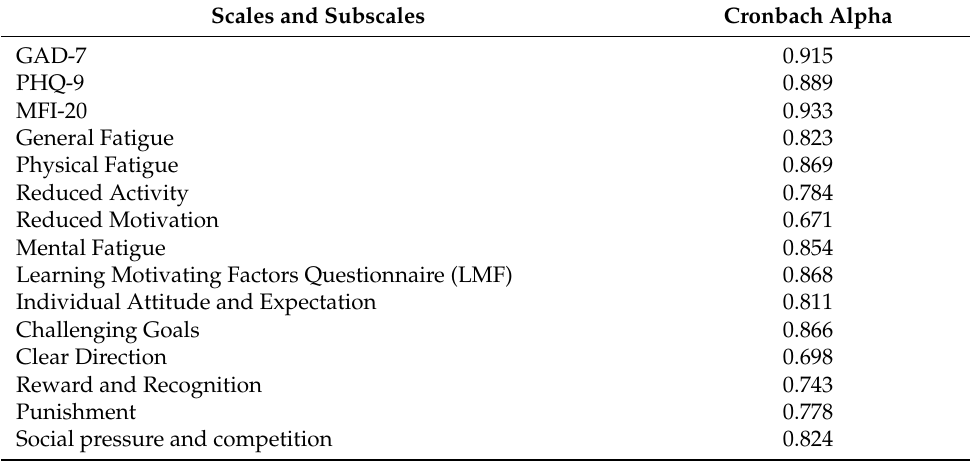
Table 1. Cronbach alphas for the Patient Health Questionnaire-9 (PHQ-9), the Generalized Anxiety Disorder Scale-7 (GAD-7), the Multidimensional Fatigue Inventory-20 (MFI-20), and the Learning Motivating Factors